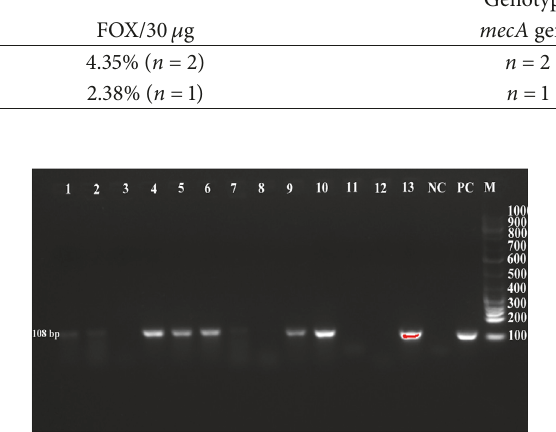
Figure 1: PCR detection for S. aureus isolates: lanes 3, 8, 11, and 12 are negative, while lanes 1, 2, 4, 5, 6, 7, 9, 10, and 13 are positive for S. aureus target gene (gltB) at 108 bp. NC and PC are negative and positive controls, respectively; M: DNA ladder marking from 100 bp to 1